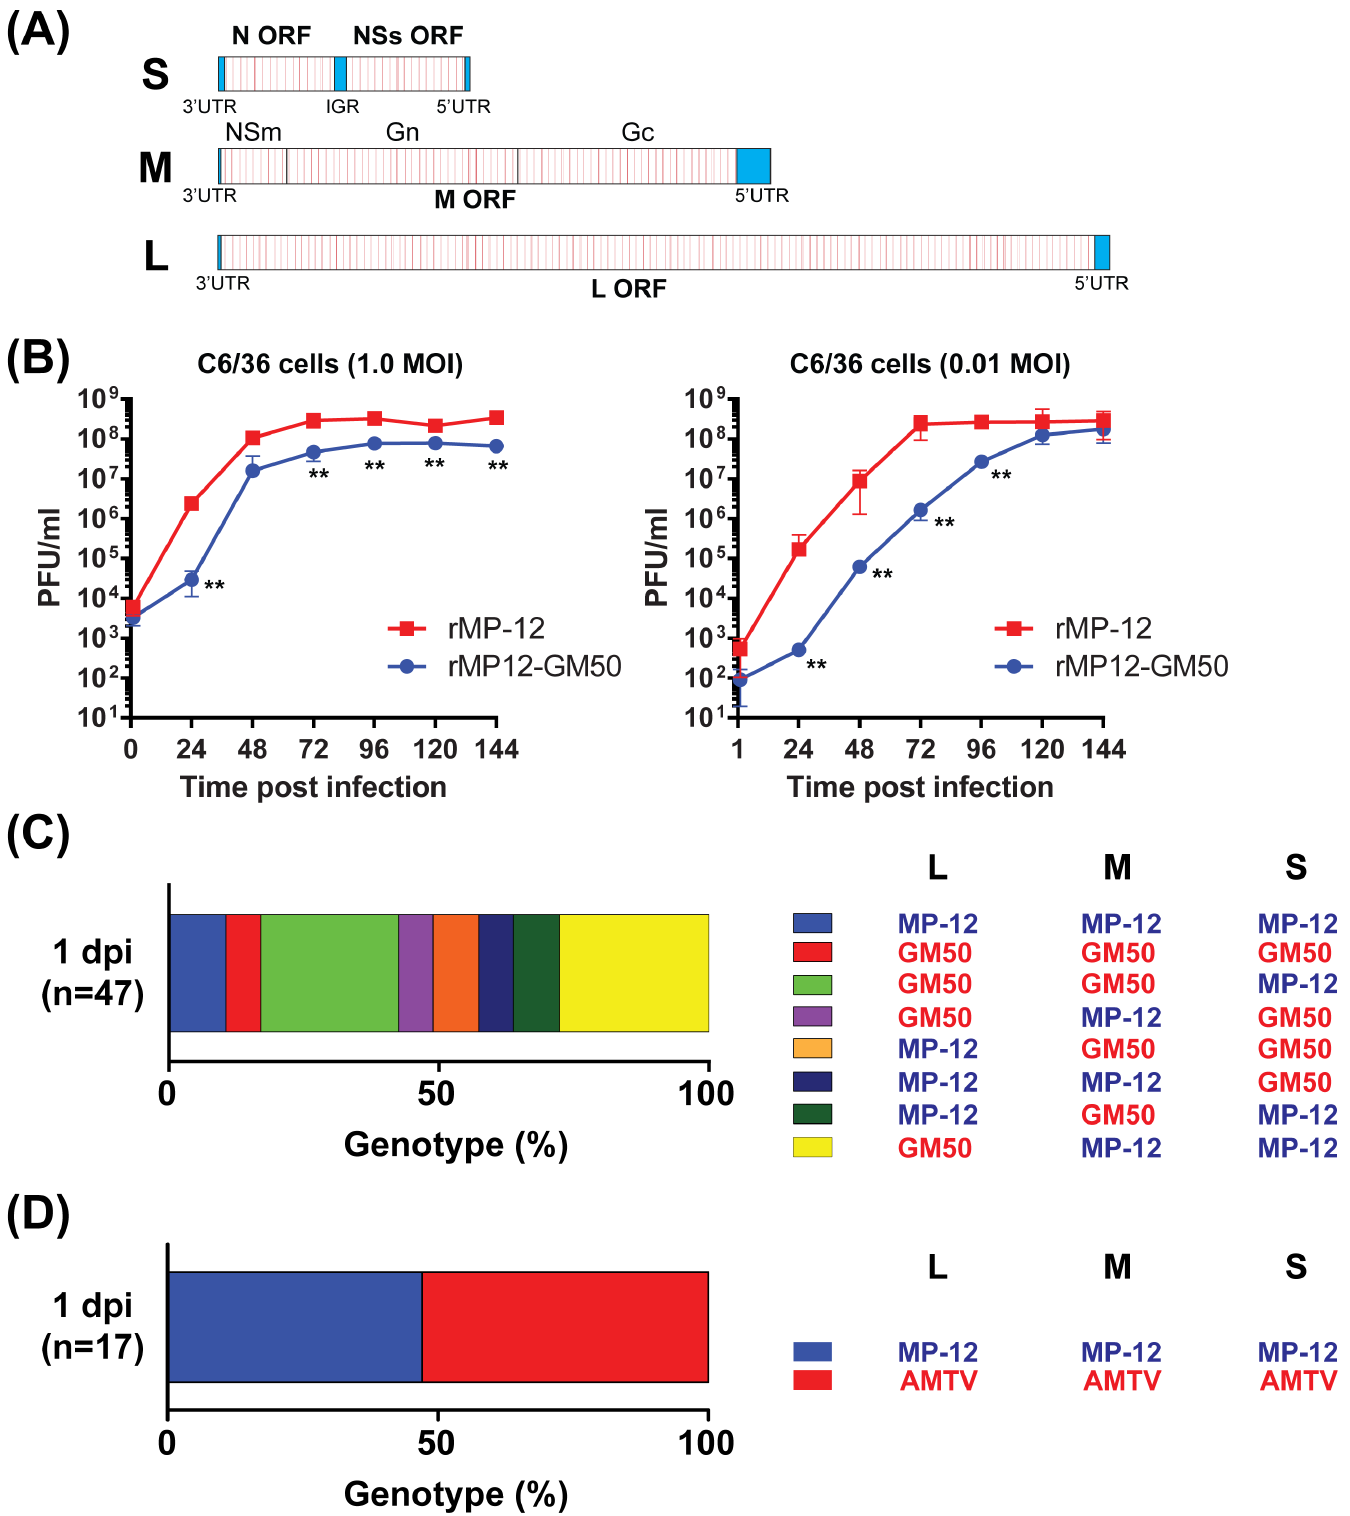
Fig 5. Reassortant formation between rMP-12 and rMP12-GM50 strains, or between rMP-12 and Arumowot virus (AMTV). (A) The schematics of the rMP12-GM50 L-, M-, and S-segments. The rMP12-GM50 strain encodes326, 185, and 73 silent mutations in the L-, M-, and S-segments, respectively.